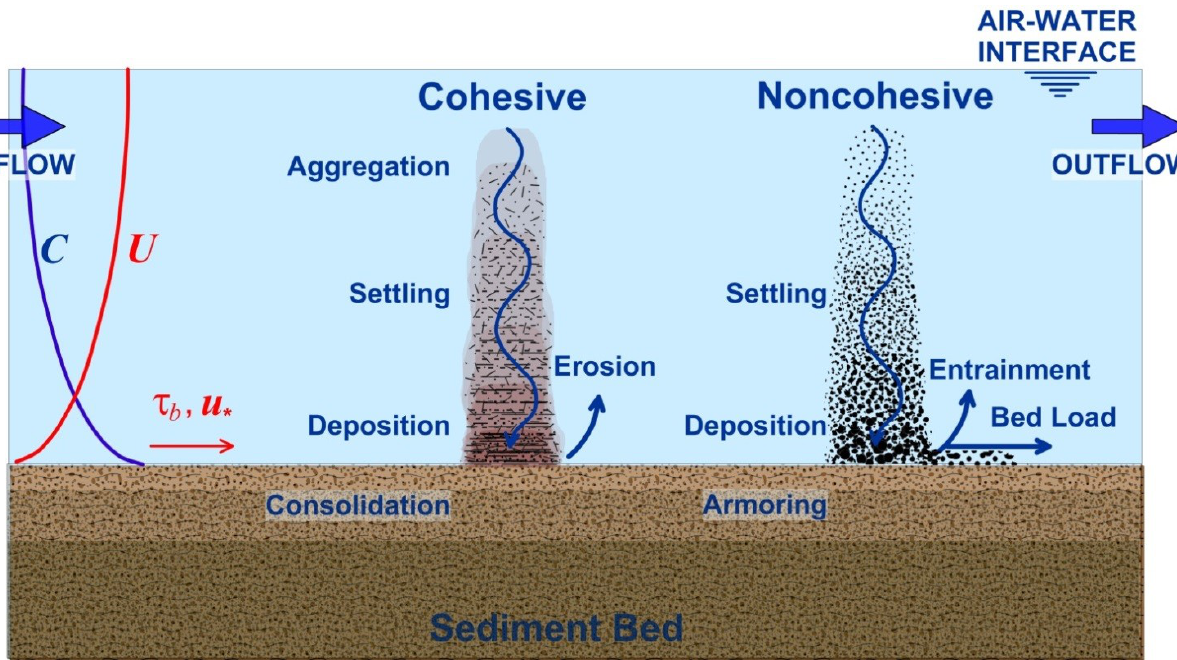
is the bed shear stress, and u is the shear b *